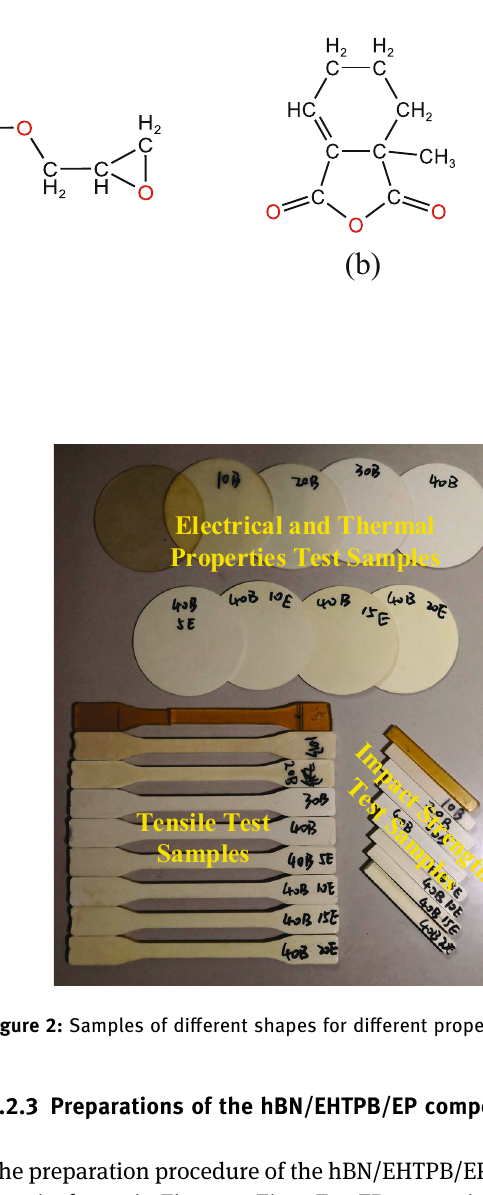
Figure 2: Samples of di ff erent shapes for di ff erent property